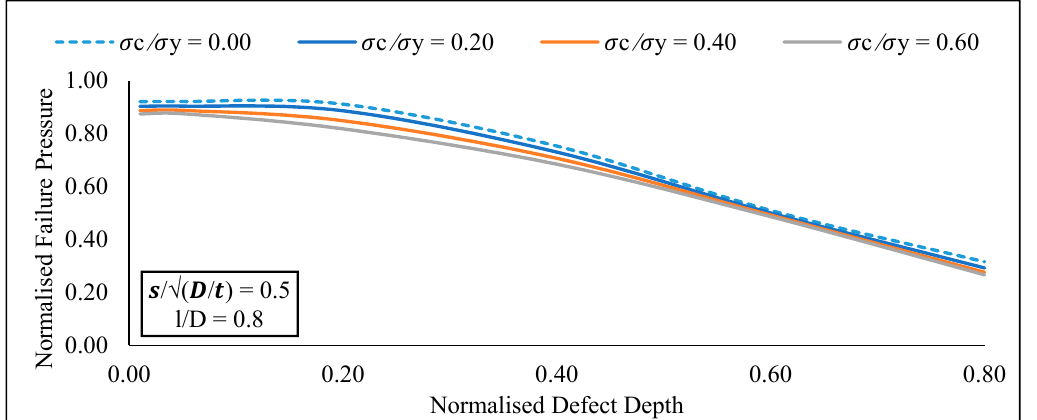
Figure 11. Normalized failure pressure against normalized defect depths for various longitudinal compressive stresses at a constant normalized defect spacing and normalized defect length.